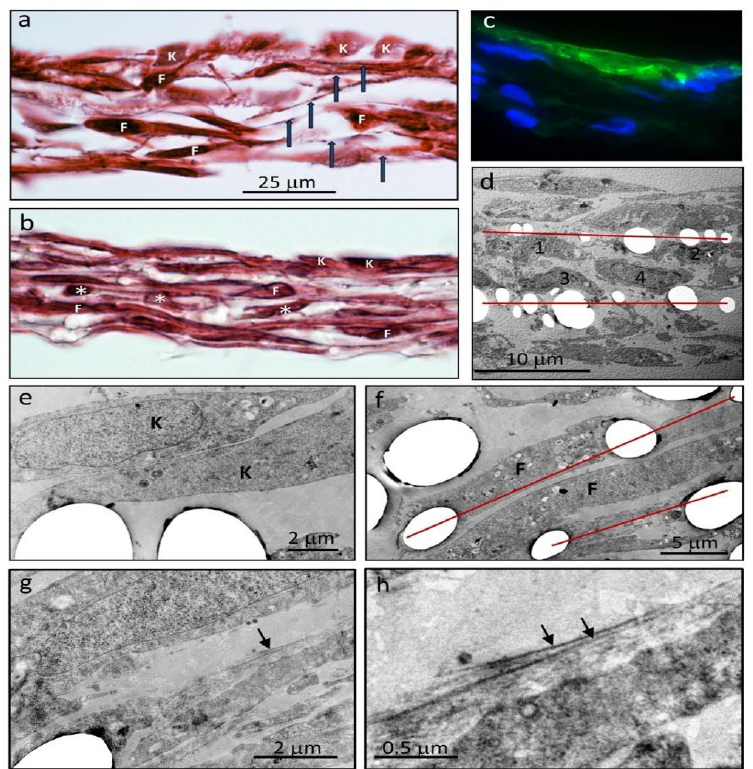
Figure 3. Histology and ultrastructure. ( a ) Histological section of skin layer formed from six stacked layer frames, cultured for 7 days, stained with hematoxylin and eosin. Five layer frames were seeded with dermal fibroblasts (F) on each side of the fiber mesh before stacking. The sixth layer frame was seeded with dermal fibroblasts on one side and 24 h later with keratinocytes (K) on the other side. During assembly of the layer frames, the layer frame with keratinocytes was placed on top with keratinocytes uppermost. The arrows point to the six layers of PLG fibers, stained due to cell processes extending along fibers. The separation between the six layers is due to the sampling location close to the inner margins of the stacked stainless steel layer frames. ( b ) Similar image to ( a ), but from a location at a distance from the frame margin showing a more compact arrangement of the six layers. Asterisks mark cells in a layer in which cells have been sectioned across their long axis, in contrast to the cells immediately below which are cut longitudinally. ( c ) Three-layered skin sheet immuno-fluorescently stained (green) for keratin and for cell nuclei (DAPI, blue), showing keratin deposits in upper layer. ( d ) Low-power electron micrograph of a two-layered skin sheet showing positions of dissolved PLG electrospun fibers within the skin sheet, with the plane of individual fibers of variable size marked by the red lines. Fibroblasts labeled 1 and 2 were seeded onto the underside of the upper mesh of fibers; fibroblasts labeled 3 and 4 were seeded on the top side of the lower mesh of fibers. The cells above the upper red line are keratinocytes. ( e ) Electron micrograph of keratinocytes (K) above upper layer of fibers. ( f ) Fibroblasts (F) in a multilayered skin sheet. The fibroblast marked F above the upper red line is attached to and spans two fiber elements. ( g ) Deposition of collagen fibrils (arrowed) on the edge of the pericellular matrix, and shown at higher magnification in panel ( h